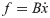
(A) Experimental setup and trial types. While sitting in front of a computer screen, subjects made reaching movements toward and away from the body (along the y axis) while holding the handle of the robotic manipulandum. Null trials were movements during which the motors of the manipulandum were turned off. There were three trial types during which the motors of the manipulandum were turned on. (B) During position-dependent force-field trials, the motors of the manipulandum produced forces on the hand (blue arrows) that were proportional in magnitude and perpendicular in direction to the position of hand motion (blue arrow). Forces (f) were calculated as a function of hand position: f = Kx. (C) During velocity-dependent force-field trials, the motors of the manipulandum produced forces on the hand (blue arrows) that were proportional in magnitude and perpendicular in direction to the velocity of hand motion (blue arrow). Forces were calculated as a function of hand velocity: f=Bx˙. (D) During error-clamp trials, the robot motors constrained the movements in a straight line toward the target by counteracting any motion perpendicular to the target direction.